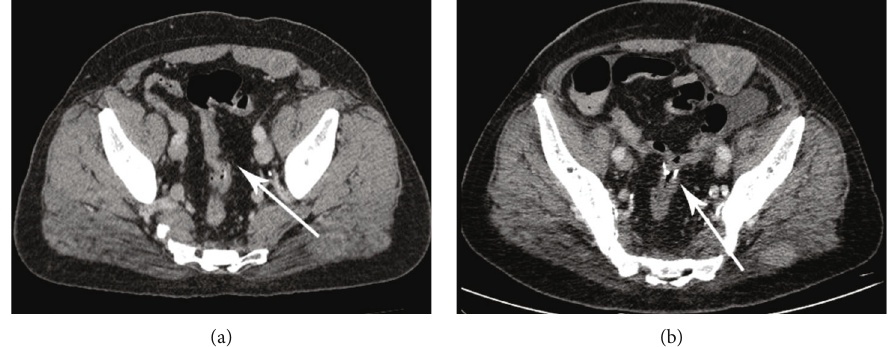
Figure 1: (a) The preoperative CT scan shows a stricture of the sigmoid colon. (b) A resection of the sigmoid colon was performed and the segment sent for histological